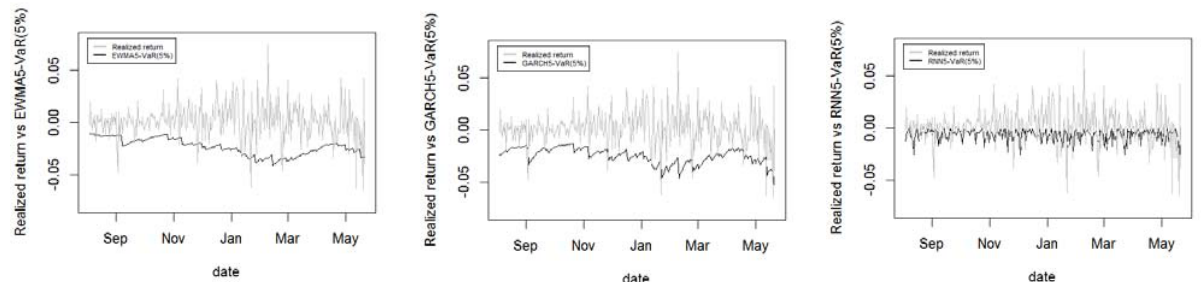
Figure 10. Out of sample realized return vs 1 day ahead VaR(5%) of EWMA, GARCH and RNN model